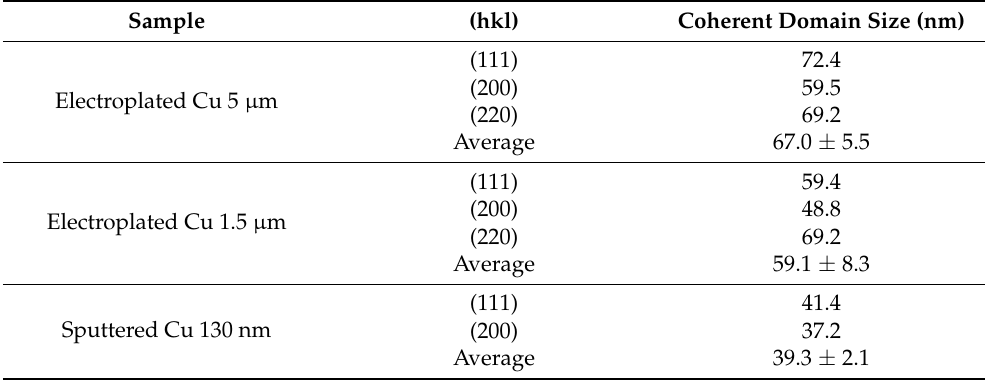
Table 2. Coherent domain size of Cu thin